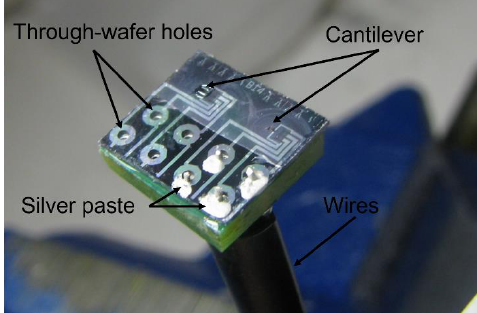
Figure 7. Photo showing two sensors glued on a PCB board.